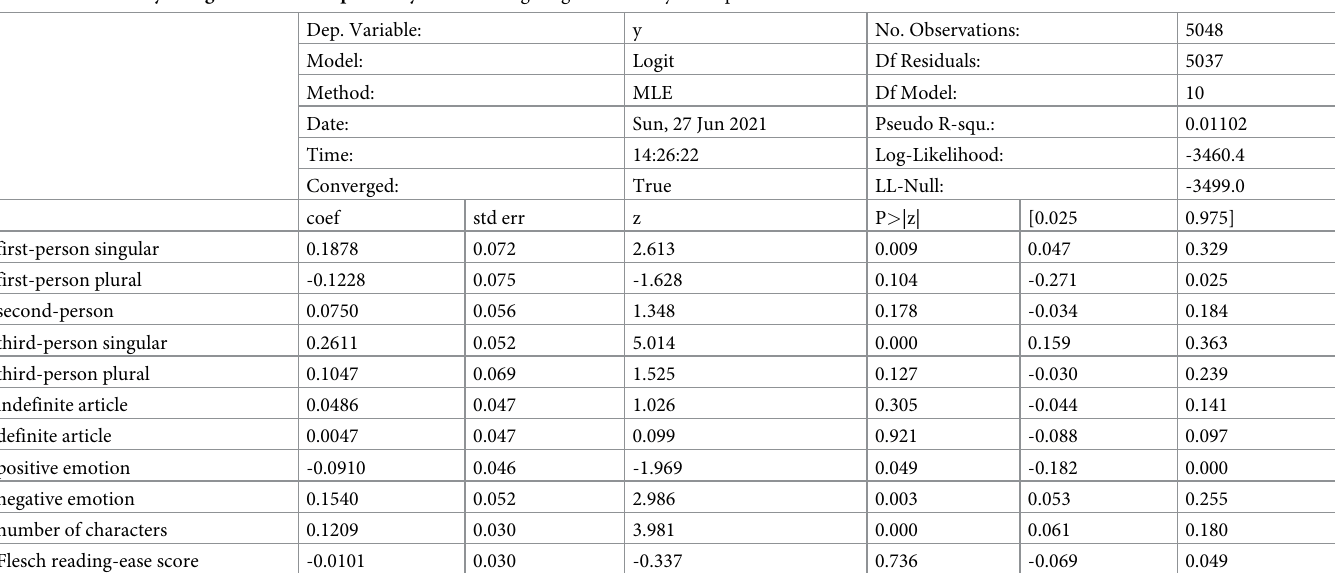
Table 4. Main analysis regression with Exploratory Dataset. Logit regression analysis for pilot